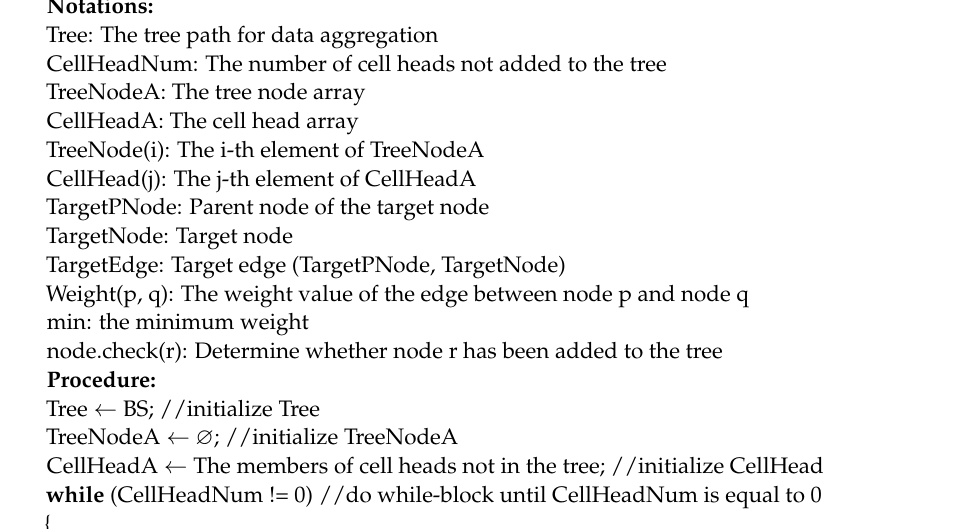
Algorithm 1: GB-PEDAP Tree Construction